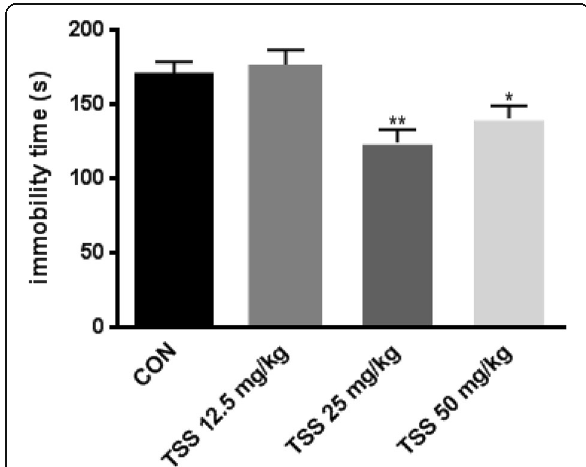
Fig. 2 Effects of TSS (12.5 、 25 、 50 mg/kg) on the forced swim test. Data were analyzed by one-way ANOVA followed by Student- Newman-Keuls test. Each bar represents the mean±SEM ( n =10 – 11). ** P <0.01, * P <0.05, as compared with the control group